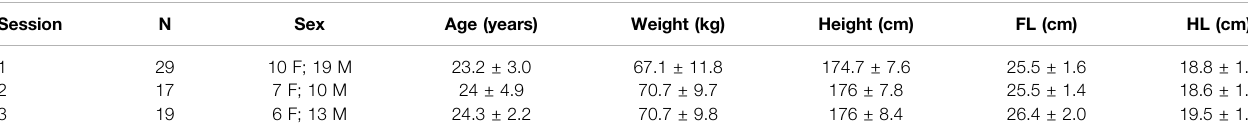
TABLE 1 | Data relative to the participants: N is the number of participants, FL is the forearm length and HL is the hand length. Session N